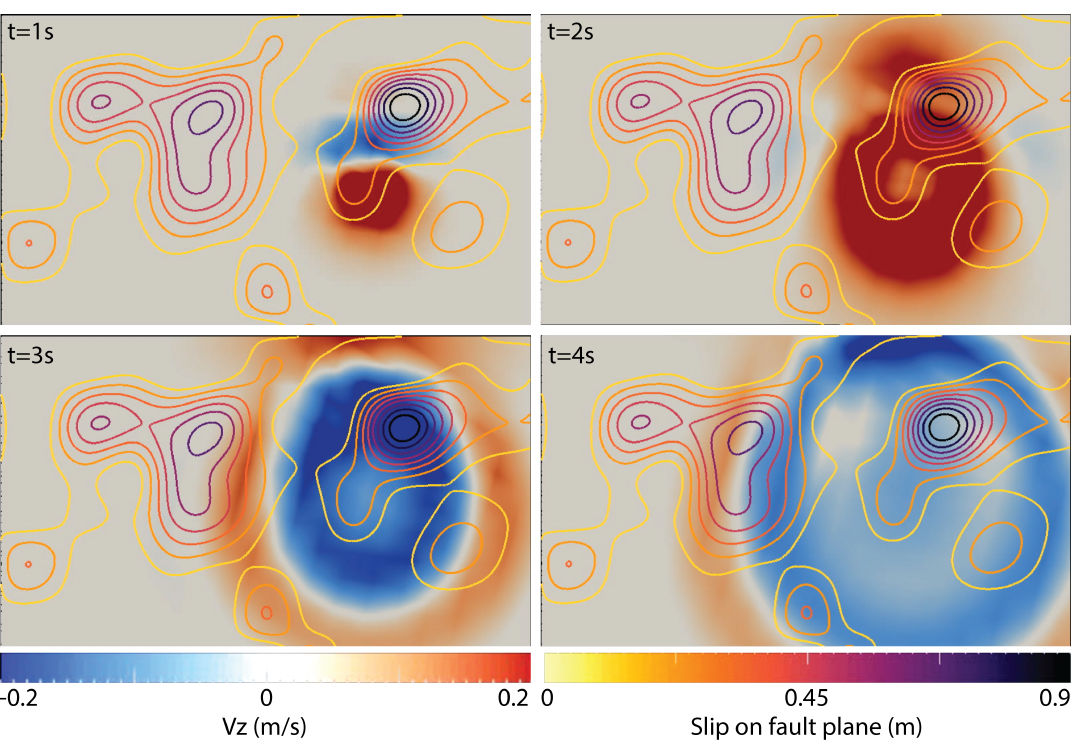
Figure 4: Snapshots of the seismic wave propagation on the fault plane proposed by [Tinti et al.(2016)]. Contour levels show the slip on the fault plane. Full color plots are the vertical component of the velocity wavefield and the wave propagation is consistent with a normal 50 ◦ SW dipping